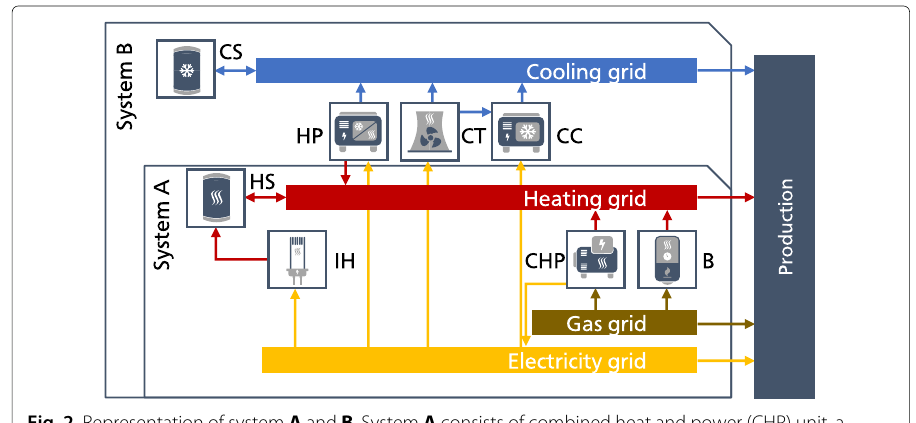
Fig. 2 Representation of system A and B . System A consists of combined heat and power (CHP) unit, a condensing boiler (B) , an immersion heater (IH) and a hot thermal energy storage (HS) providing heating, electricity and gas through the grids. System B additionally contains the cooling grid with a heat pump (HP) between cooling and heating grid, a cooling tower (CT), a compression chiller (CC) and a cold thermal energy storage (CS) (Panten